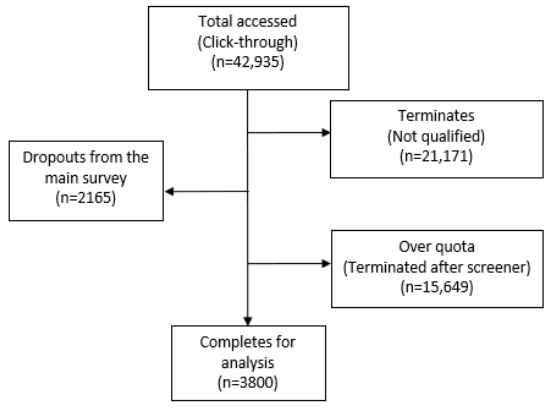
Figure 1. Flow chart of survey response rate.